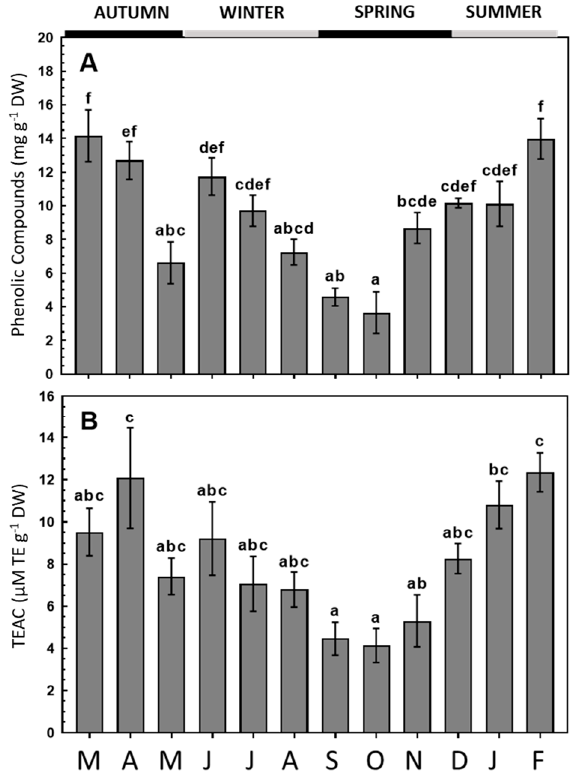
Figure 9. ( A ) Phenolic compounds content (mg g − 1 DW), and ( B ) Trolox equivalent antioxidant capacity (DPPH method), quantified in L. spicata collected at Cochoa Beach, Viña del Mar, Chile, from autumn to summertime. Letters indicate significant differences after the SNK test ( p < 0.05).